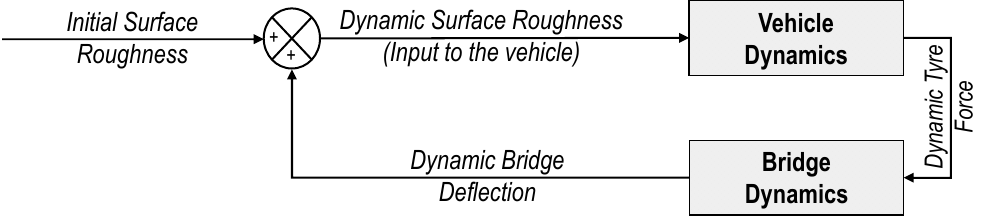
Figure 2. Schematic block diagram of dynamic bridge-vehicle interaction.